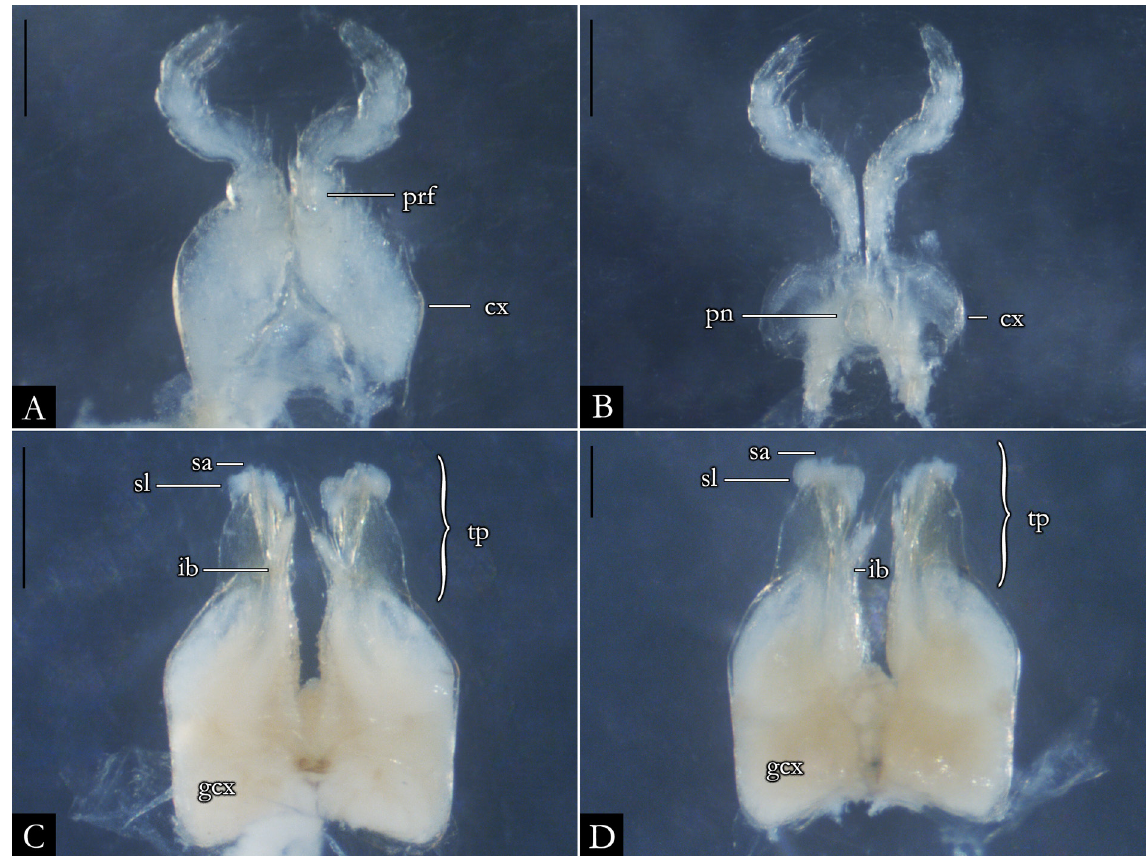
Fig. 116. Pseudonannolene rocana Silvestri, 1902, ♂ (NHMD). A . First leg-pair. B . Second leg-pair. C . Gonopods, in anal view. D . Gonopods, in oral view. Abbreviations: see Material and methods. Scale bars = 0.5